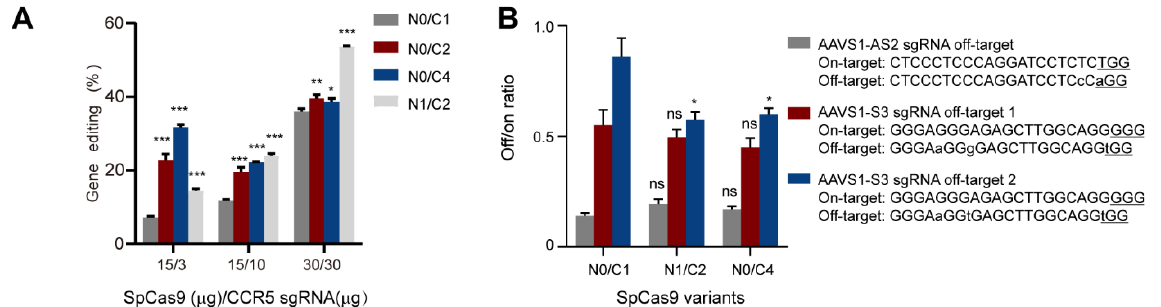
Figure 4. Evaluation of the effects of multi-NLS on SpCas9 activity and specificity in K562 cells. ( A ) The gene-editing activities of multi-NLS on SpCas9 at different dosage, as determined by T7E1 analysis. The data are shown as mean ± SD ( n = 3 technical replicates). ( B ) The effects of multi-NLS on the specificity of SpCas9 variants. The specificity is determined by the ratio between on-target and off-target activities. The difference between N0/C1 and multi-NLS constructs at each corresponding condition is analyzed by one-way ANOVA with Bonferroni’s multiple comparisons test. *, p < 0.05; **, p < 0.01; ***, p < 0.001.